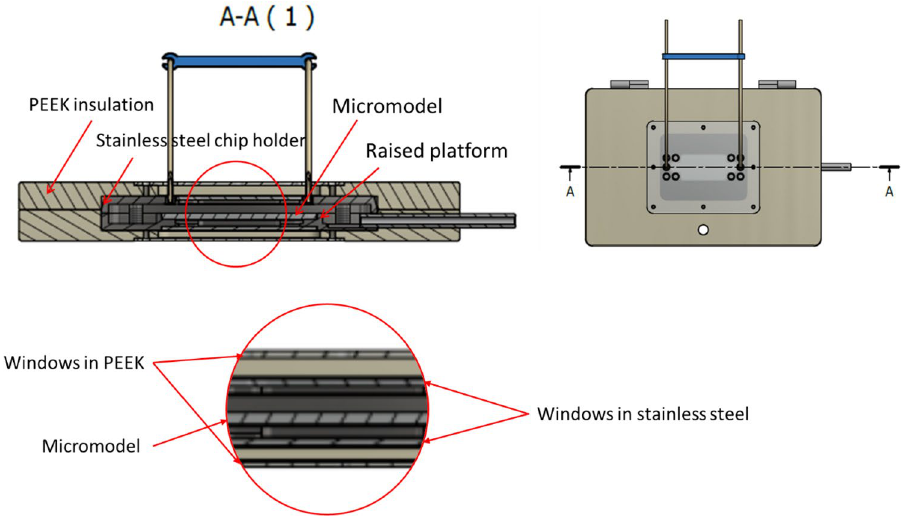
Figure 10. The high temperature—high pressure (HTHP) chip holder design. The hatched area of the cross section shows where there is material, and the rest showing the open space for air circulation. Technical drawing courtesy of Robert Karlsen, Engineer at the Mechanical Engineering Workshop at NV Faculty,